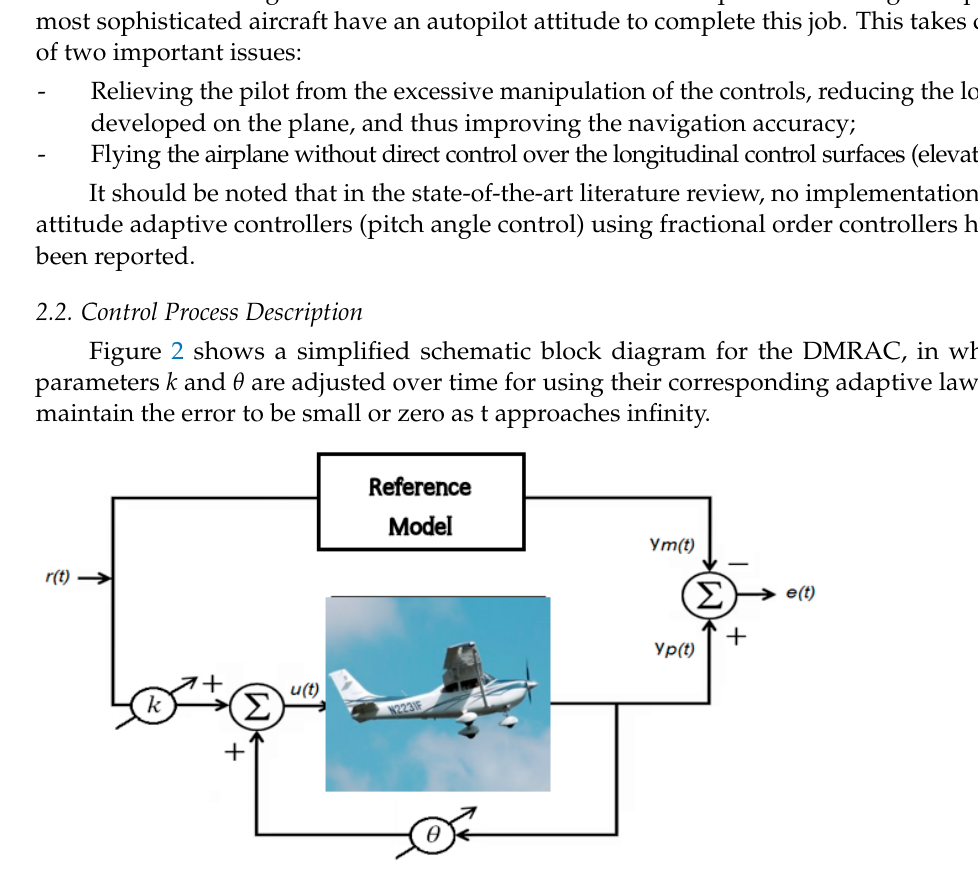
Figure 2. Block diagram of the DMRAC scheme.